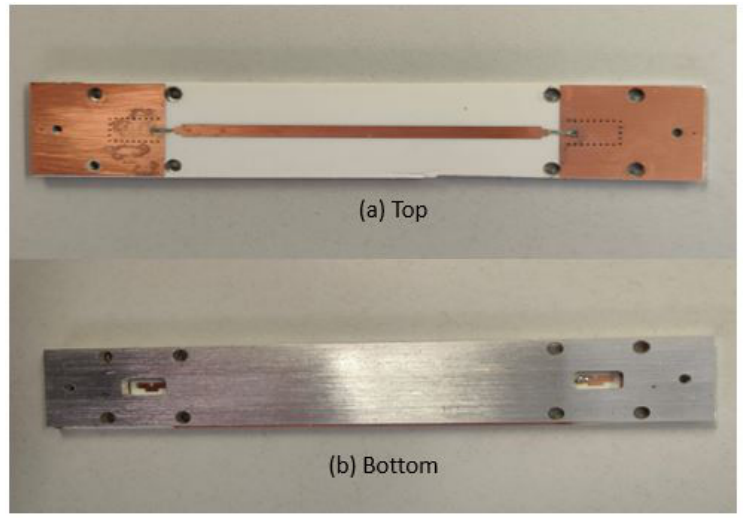
Figure 9. Top view and bottom view of the B2B manufactured BS